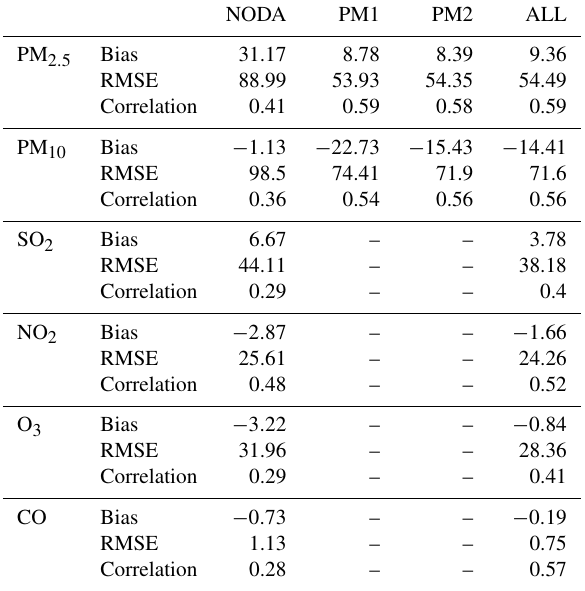
Table 3. Averaged bias (units: µgm − 3 ), RMSE (units: µgm − 3 ), and correlation over forecast hours 0–24h for different variables and different experiments. The statistics for gas-phase pollutants in PM1 and PM2 experiments are very close to the results in the NODA experiment and thus are left blank in the